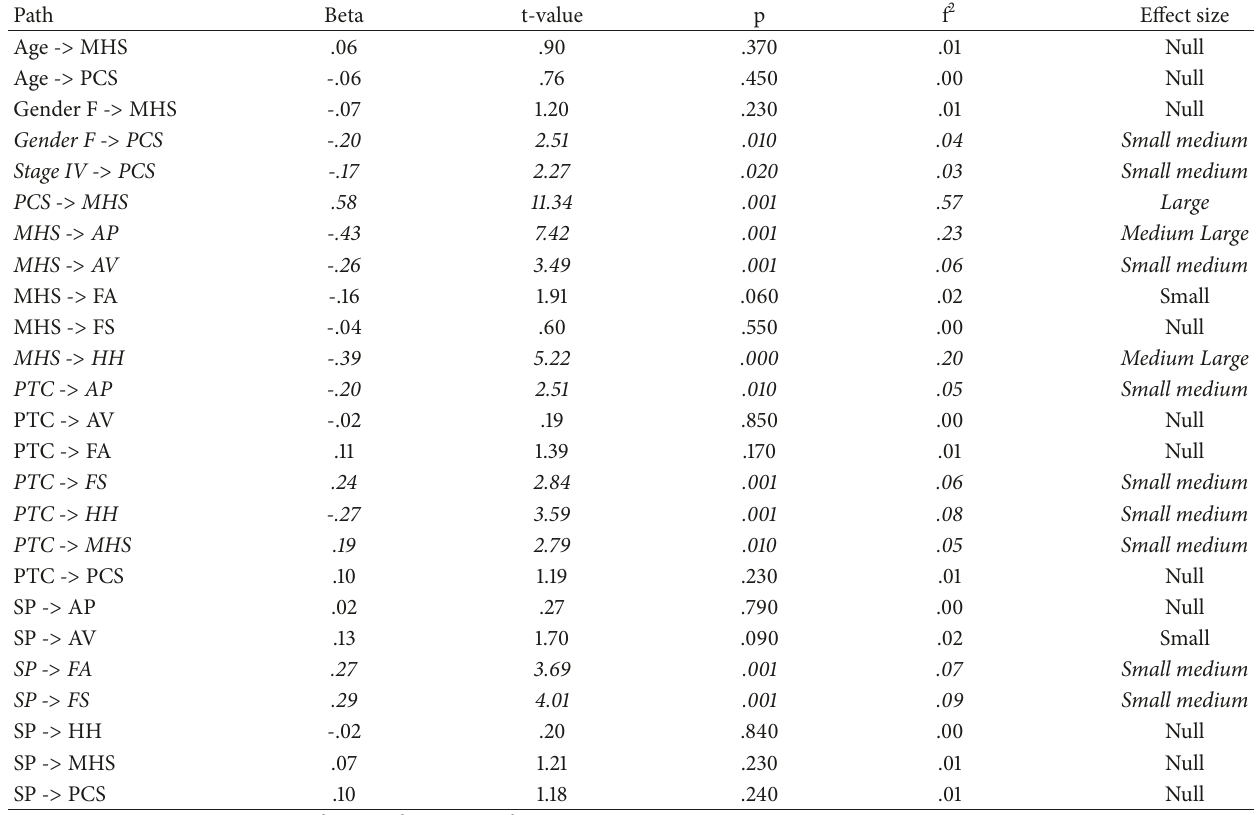
Table 3: Tests of model coefficients.